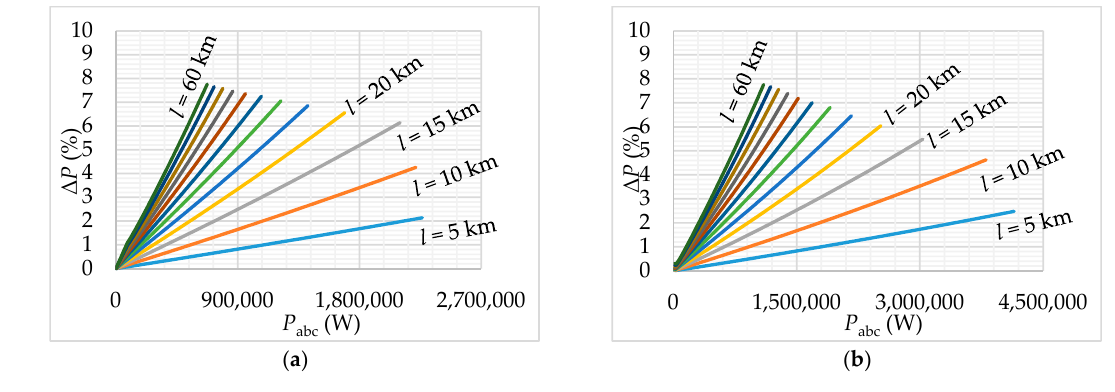
Figure 9. Scenario 3: ( a ) ACSR 42/7; ( b ) ACSR 70/11.